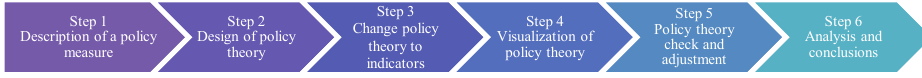
Fig. 2. Theory-based policy analysis